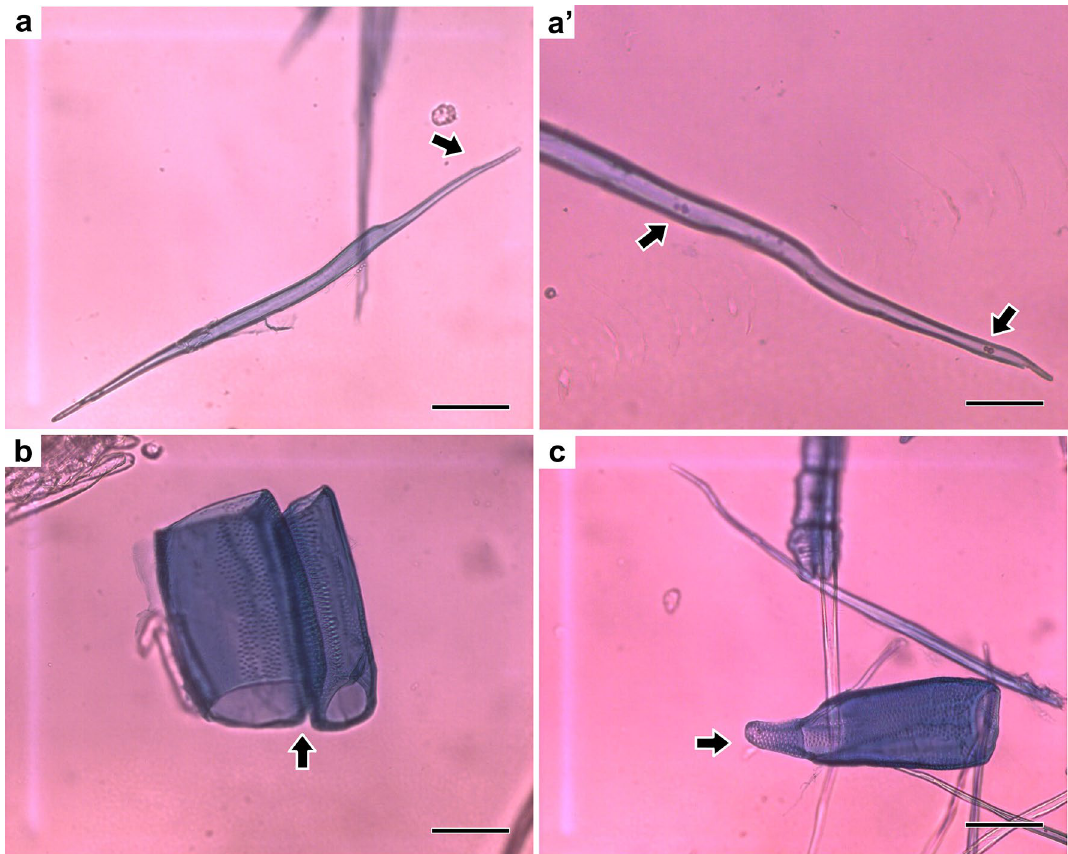
Figure 4. Observation of individualized anatomical elements: libriform fibers with tapered ends ( a ); magnification of libriform fiber pointing simple pit (a’) ; vessel elements in contact ( b ) and solitary with the presence of an appendix ( c ) Scale bars = 100